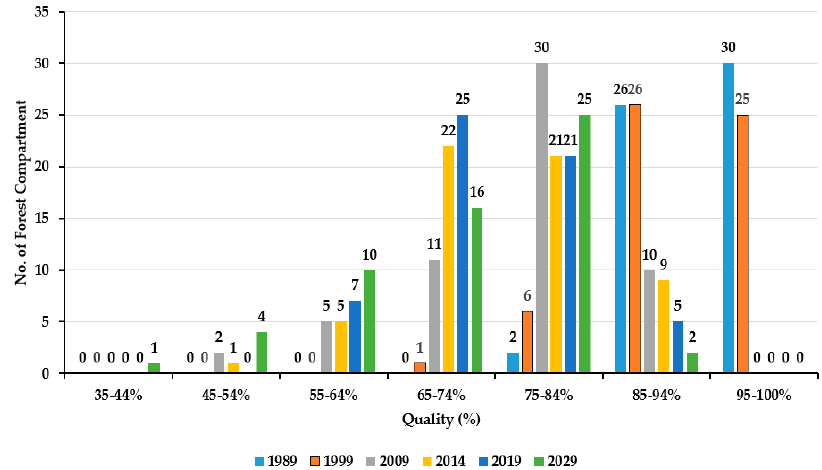
Figure 9. Spatial forest health quality assessment in SRF in 1989–2029 based on the forest compartments. Note: the number of forest compartments is displayed as a data label for the corresponding year maintaining quality (%) of forest cover in the SRF.